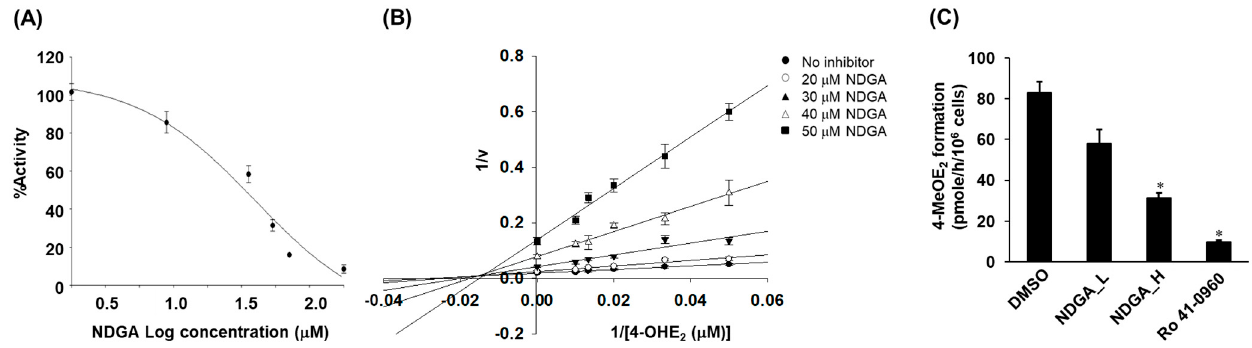
Figure 2. Inhibition of catechol O -methyl transferase by nordihydroguaiaretic acid. COMT activity was calculated as a percentage with the peak area for 4- O -methylated hydroxyestradiol obtained in the HPLC-DAD analysis set as 100 with no inhibitor present. The IC 50 value of NDGA-mediated COMT inhibition of 4-hydroxyestradiol methylation was obtained by incubating COMT in the presence of various concentrations of NDGA and 4-OHE 2 (50 µM) ( A ). The inhibition kinetic parameters were further analyzed using a double-reciprocal plot ( B ). Inhibition of COMT-catalyzed 4-OHE 2 methylation in whole cell (MCF-7) lysate treated with either NDGA or Ro 41-0960 (10 μ M) ( C ). NDGA_L indicates 25 µM of NDGA, whereas NDGA_H indicates 50 µM NDGA-treated cell samples. Each data point is representative of three independent experiments. Data are shown as the mean values of three determinations ± SE. Each experiment was independently repeated at least three times. An asterisk indicates p < 0.001 between compound-treated and DMSO-treated cells.